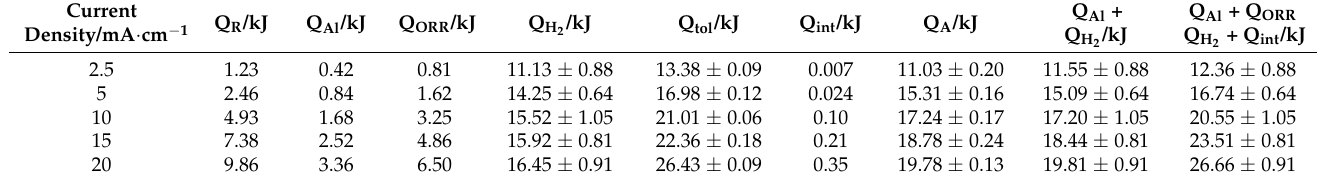
8 of 14 Figure 3. The discharge curves for the aluminum − air battery at different discharge current densi-